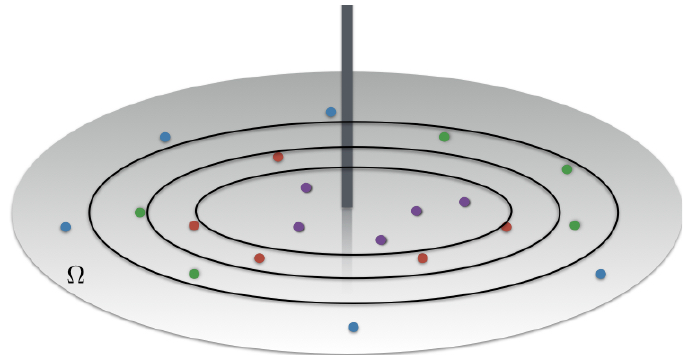
Figure 3. The optimal scheduling requires to divide the cell in equal rate subsets as a function of their channel